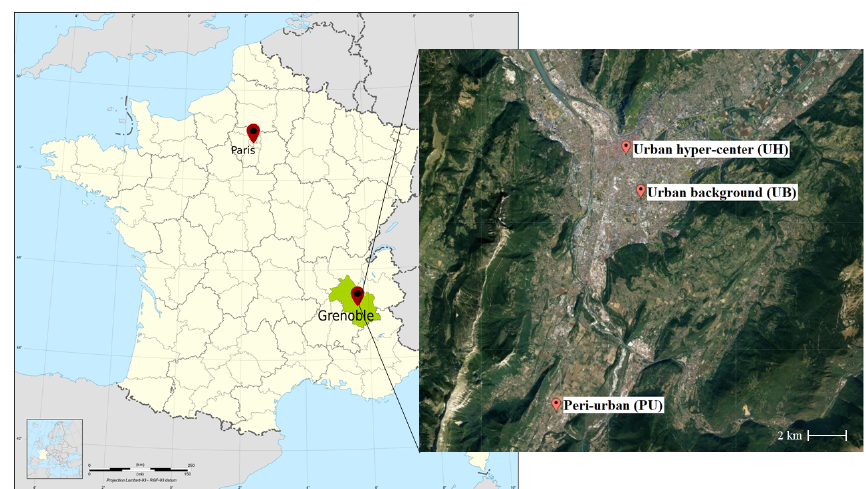
Figure 1. Study area in Grenoble (France) on a European map (left) and location of the three urban sites (right), namely Les Frênes or UB (urban reference background site), Caserne de Bonne or UH (urban hyper-centre site), and Vif or PU (peri-urban site). © OpenStreetMap contributors 2020. Distributed under the Open Data Commons Open Database License (ODbL)